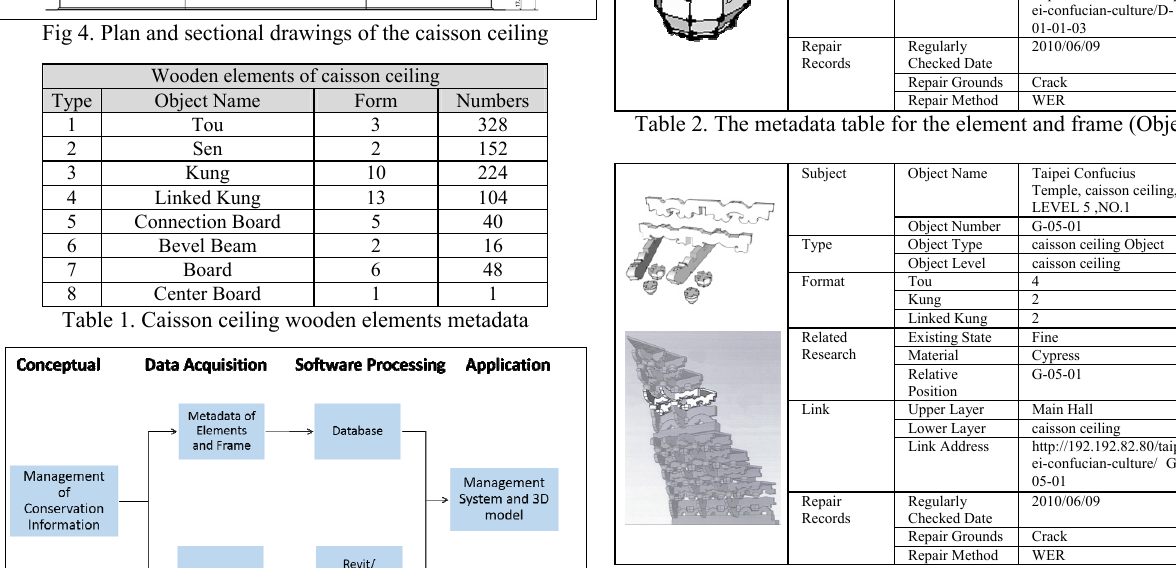
Table 3. The metadata table of elements and frame